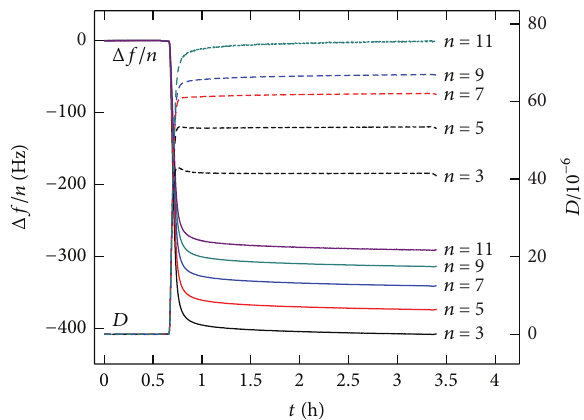
Figure 8: Time evolution of Δ𝑓/𝑛 (solid lines) and Δ𝐷 (dashed lines) during a typical QCM-D experiment of vesicle adsorption on gold-coated quartz at 16 ∘ C. Data for the DMPC + 0.1 DSPC mixture.